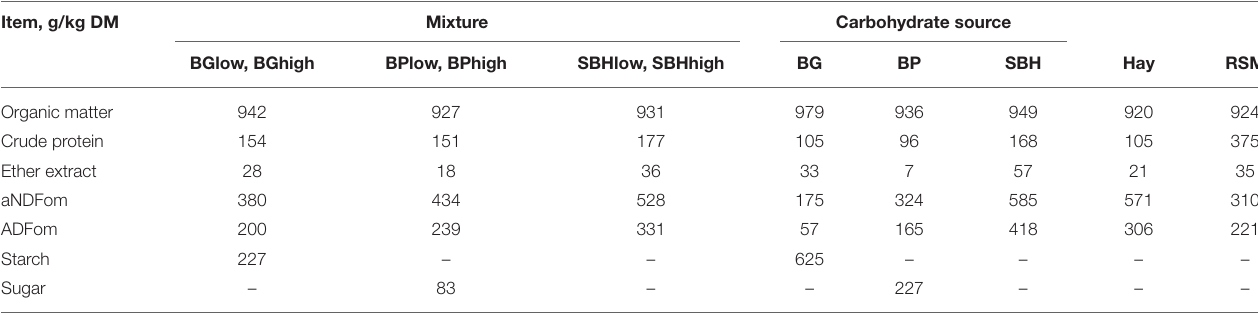
TABLE 1 | Chemical composition of the substrates containing a mixture of 5g grass hay, 2g rapeseed meal (RSM) and 4g barley grain (BG), beet pulp (BP) or soybean hulls (SBH) as carbohydrate source (on DM basis).